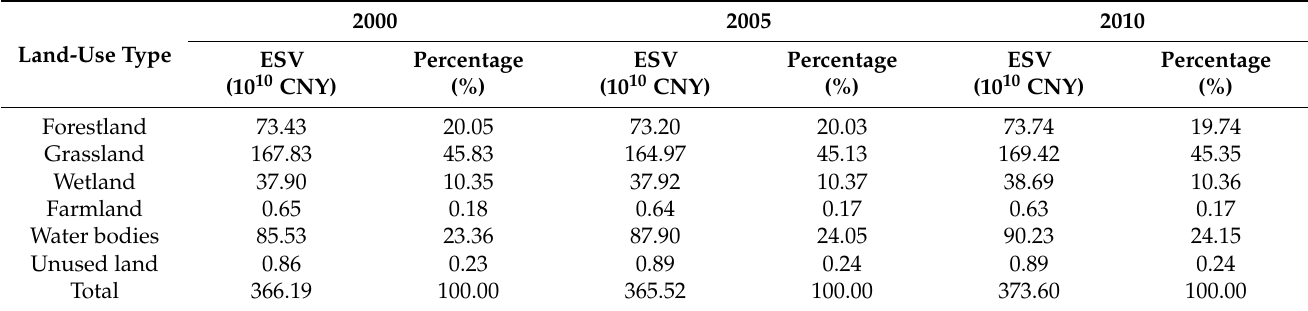
Table 4. Ecosystem services values of each ecosystem in the national nature reserves of western